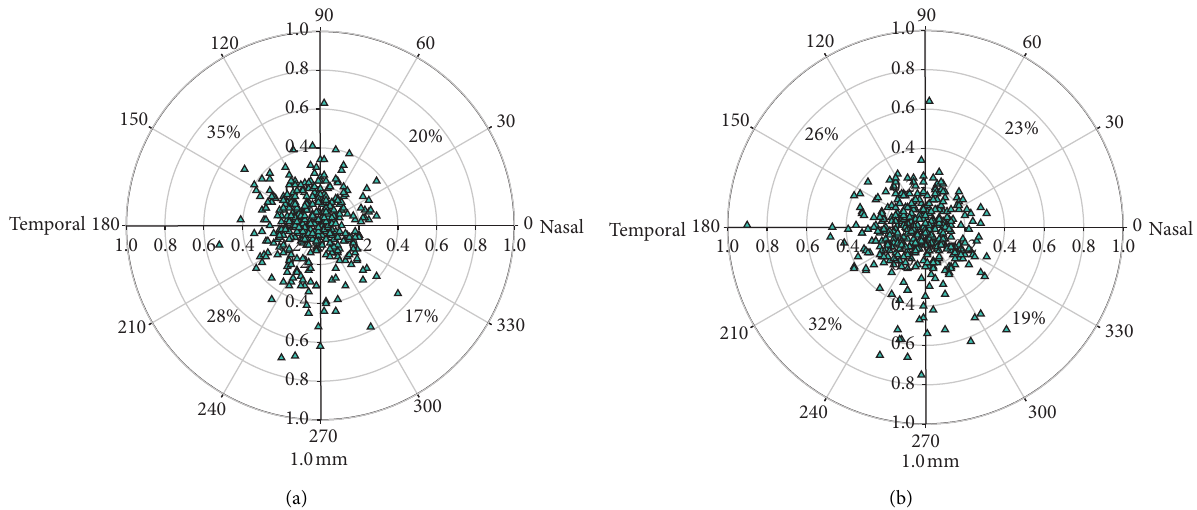
Figure 2: Decentration of the pupil center under (a) photopic and (b) mesopic conditions (the center of the coordinate is the geometric center of the cornea, and the cyan points are pupil